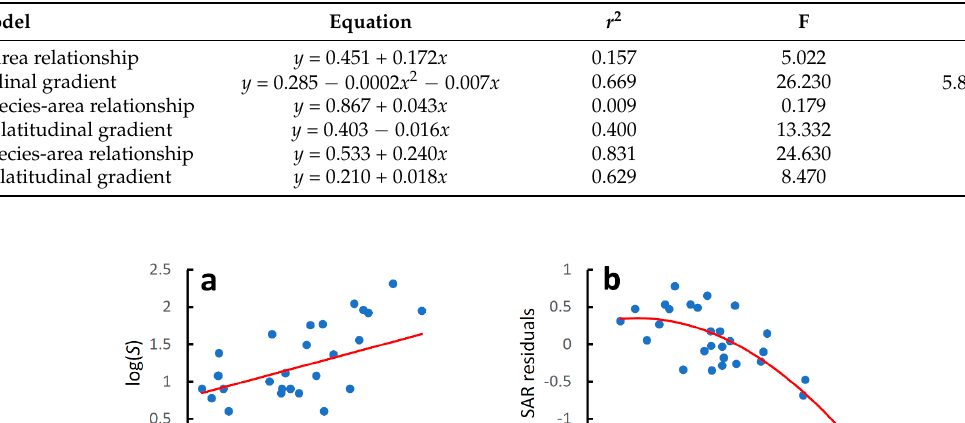
Table 3. Earwig species–area relationships and latitudinal diversity gradients for world island countries. Species–area relationships were modelled using the linearized version of the power function: log( S ) = z log( A ) + log( c ), where S is the recorded species richness at country level, A is country area, and z and c are estimated parameters. Latitudinal gradients were modelled with regressing residuals from the species–area relationships (SAR residuals) against country latitude with a second-order polynomial regression for the whole dataset and with linear regressions for the two hemispheres separately. r 2 = coefficient of determination; F = Fisher’s F; p = probability.